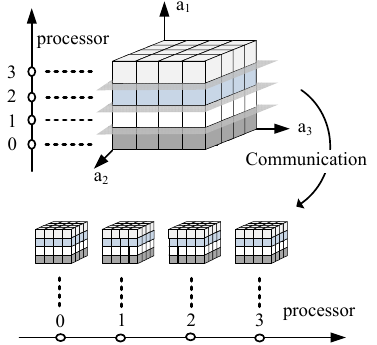
Figure 1. redundancy distribution